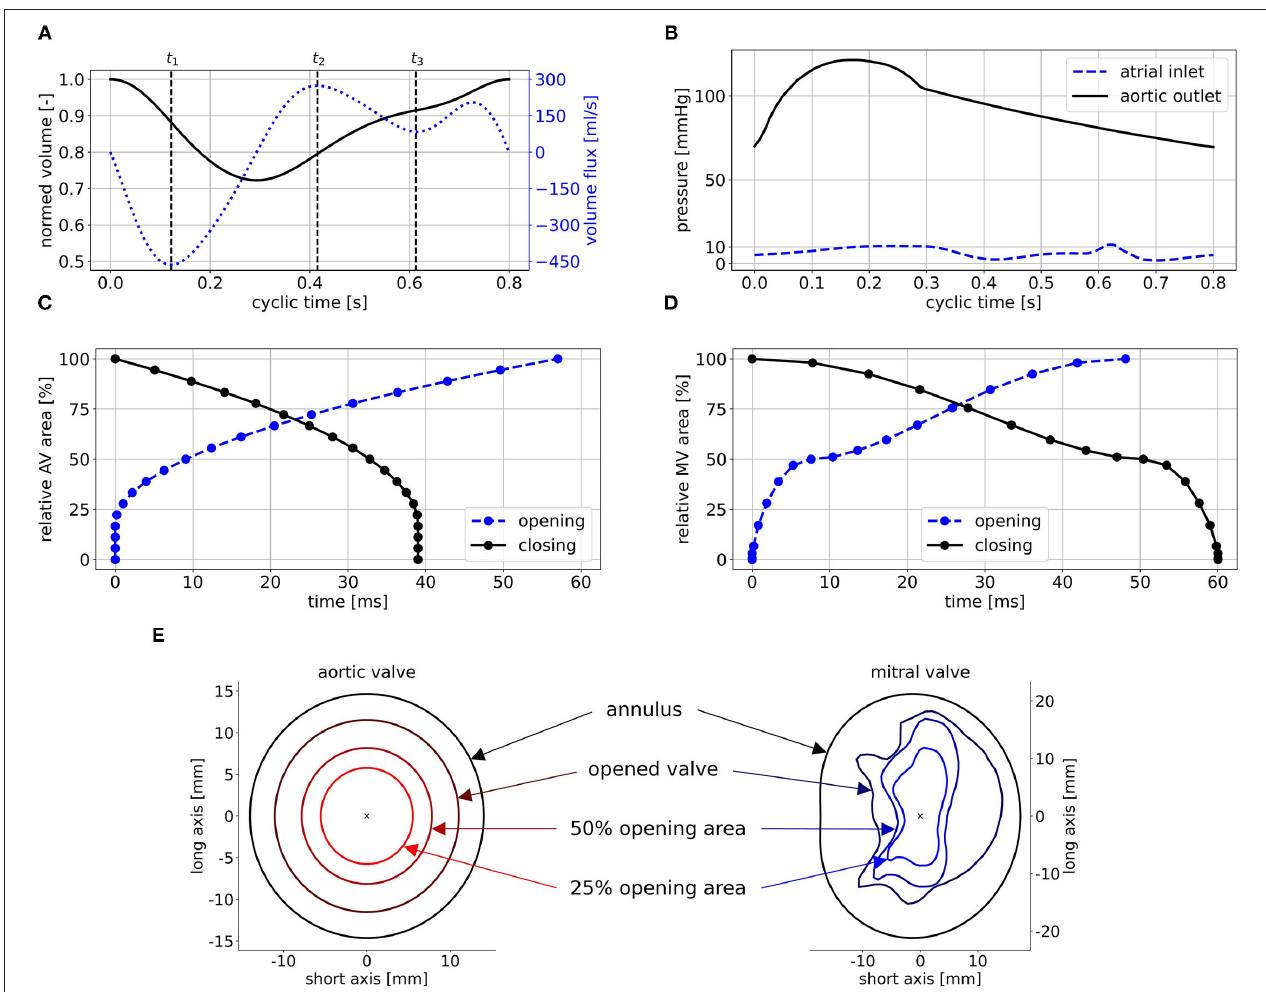
FIGURE 5 | Posed BCs exemplified for case M0A1: (A) shows the normed volume curve and the volume flux, (B) the physiological pressure BCs, (C) and (D) the opening and closing times of AV and MV, and (E) some intermediate valve shapes of the AV (left) and the MV (right) used to realize opening and closing. Time points t 1 , t 2 , and t 3 in (A) mark peak systole, peak E-wave, and